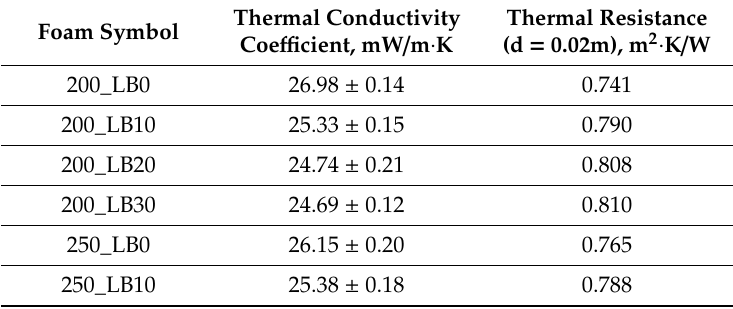
Table 6. Thermal insulation properties of the obtained